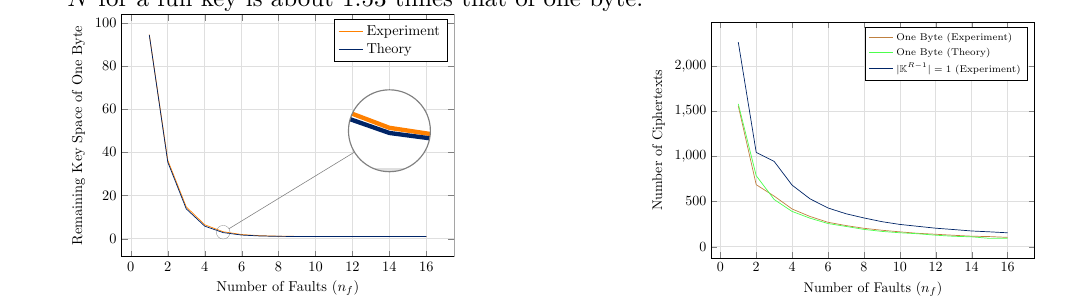
Figure 3: Single byte remaining key search space of 256 chosen plaintexts (AES-128).